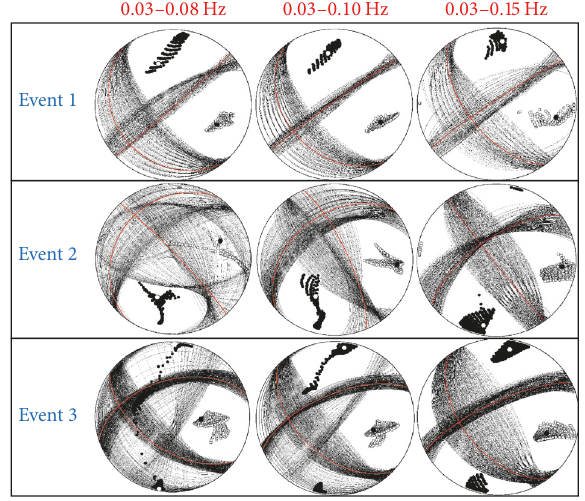
Figure 3: To understand uncertainty models, calculation of fault- plane solution for stabilities of the focal mechanism is determined from P-wave polarities. The different frequency ranges were tested to compare the inversion results. Positive and negative polarities are marked with white and black circles, respectively. Nodal lines and 𝑃 and 𝑇 axes correspond to space-time grid searches. Acceptable solutions are plotted in black nodal lines and the best fit solution marked as red nodal